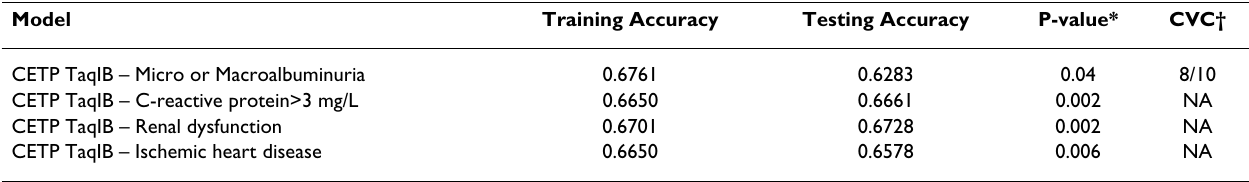
Table 3: Summary of Multi-Factor Dimensionality (MDR) results